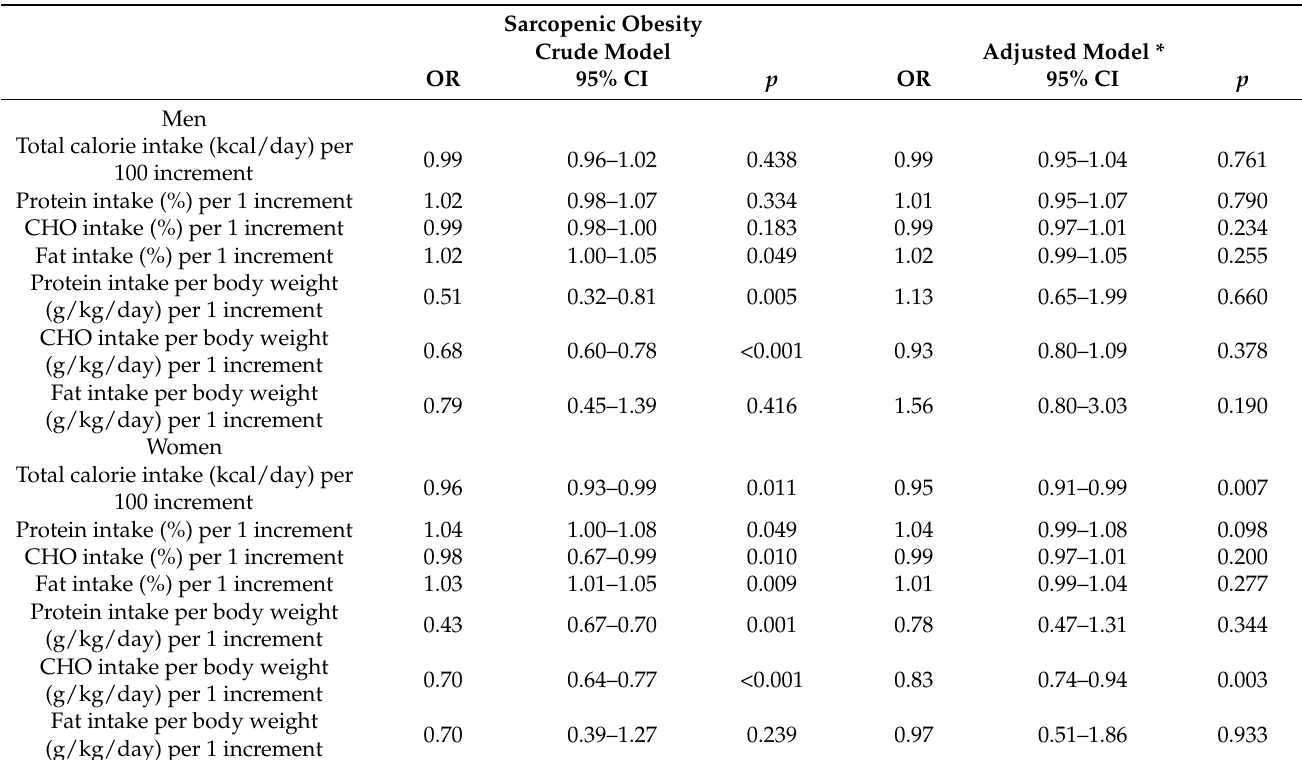
Table 2. Weighted logistic regression analysis showing relationship between macronutrient intake and sarcopenic